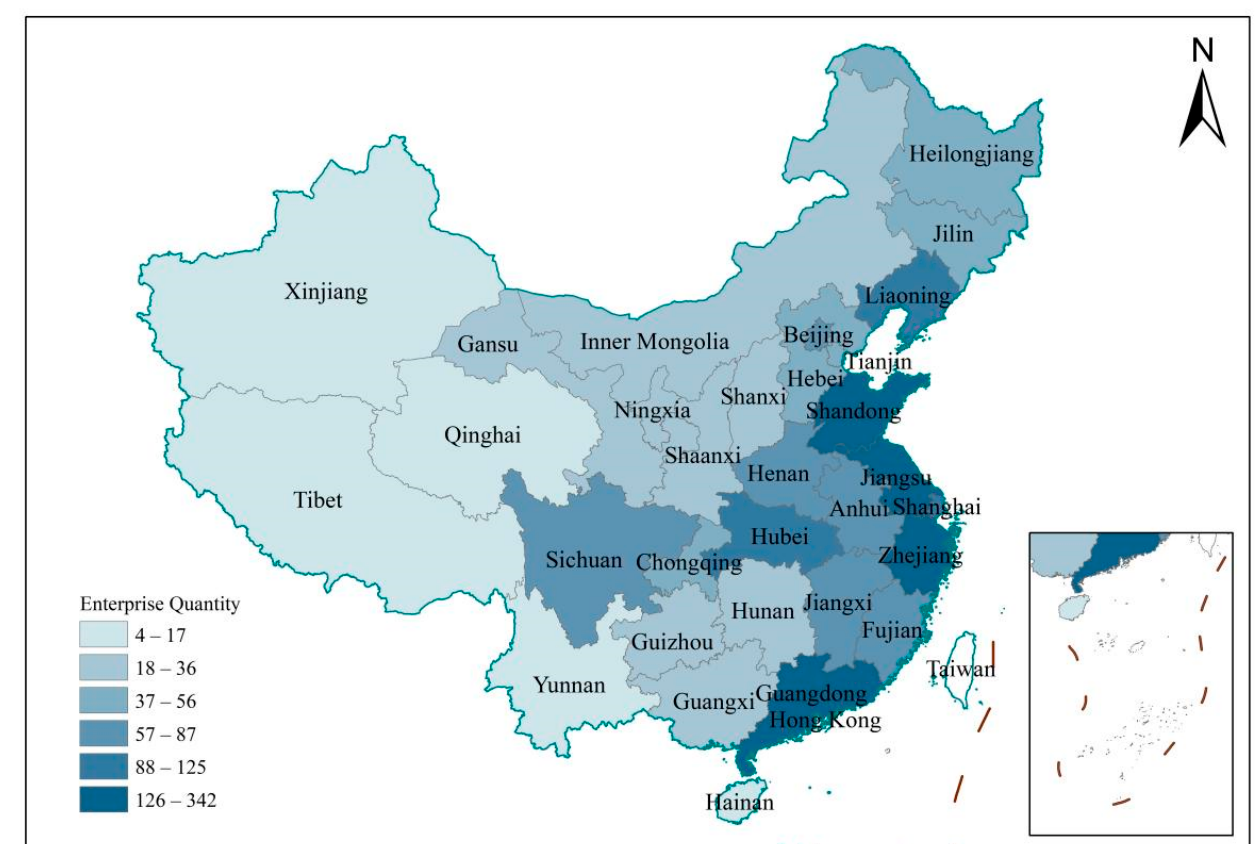
Figure 1. Spatial distribution of data.